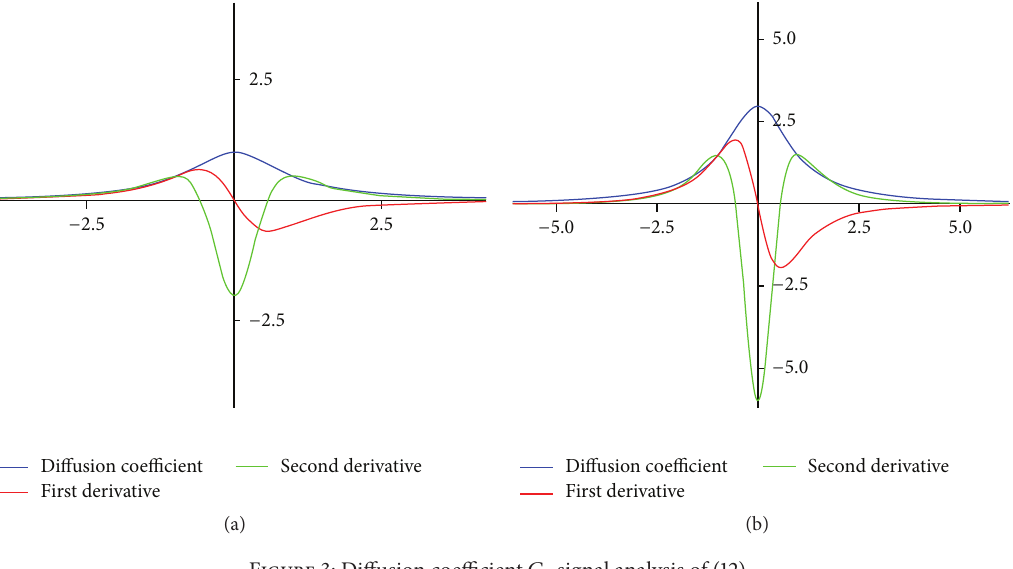
Figure 3: Diffusion coefficient 𝐶 𝑛 signal analysis of (12).